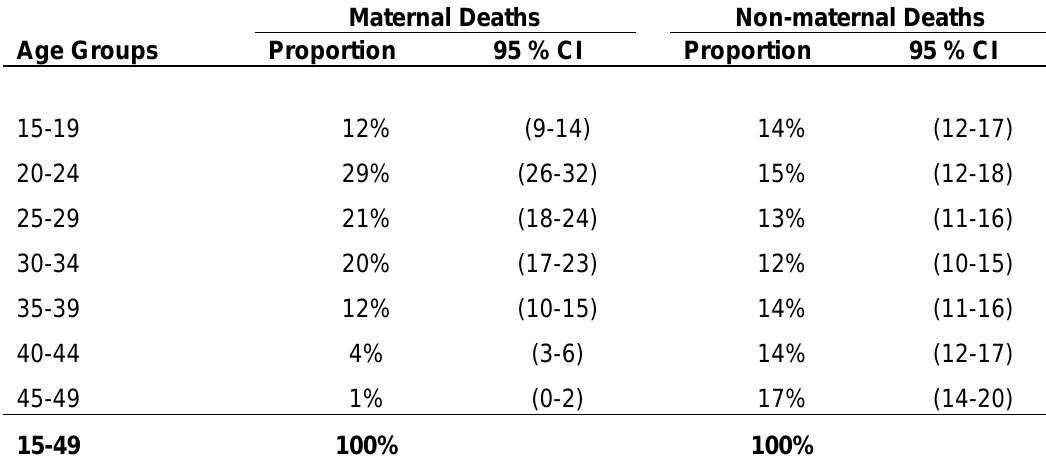
Table 4: Age Distribution of Maternal Deaths from 2001-03 Special Survey of Deaths Maternal